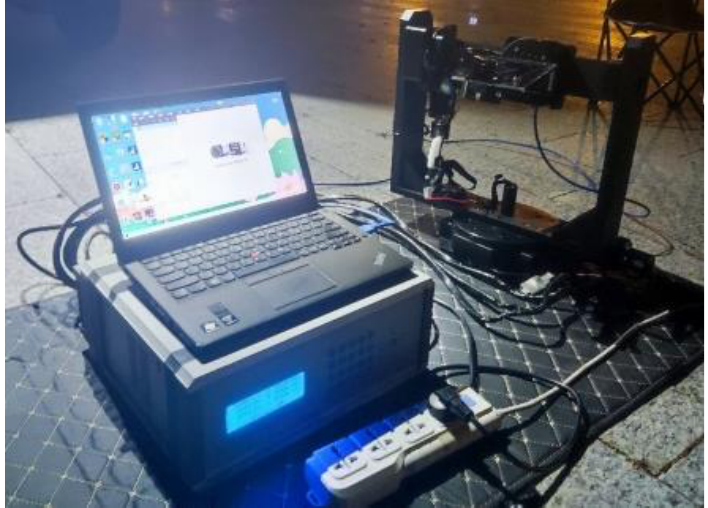
Figure 13. Diagram of field experiment system.